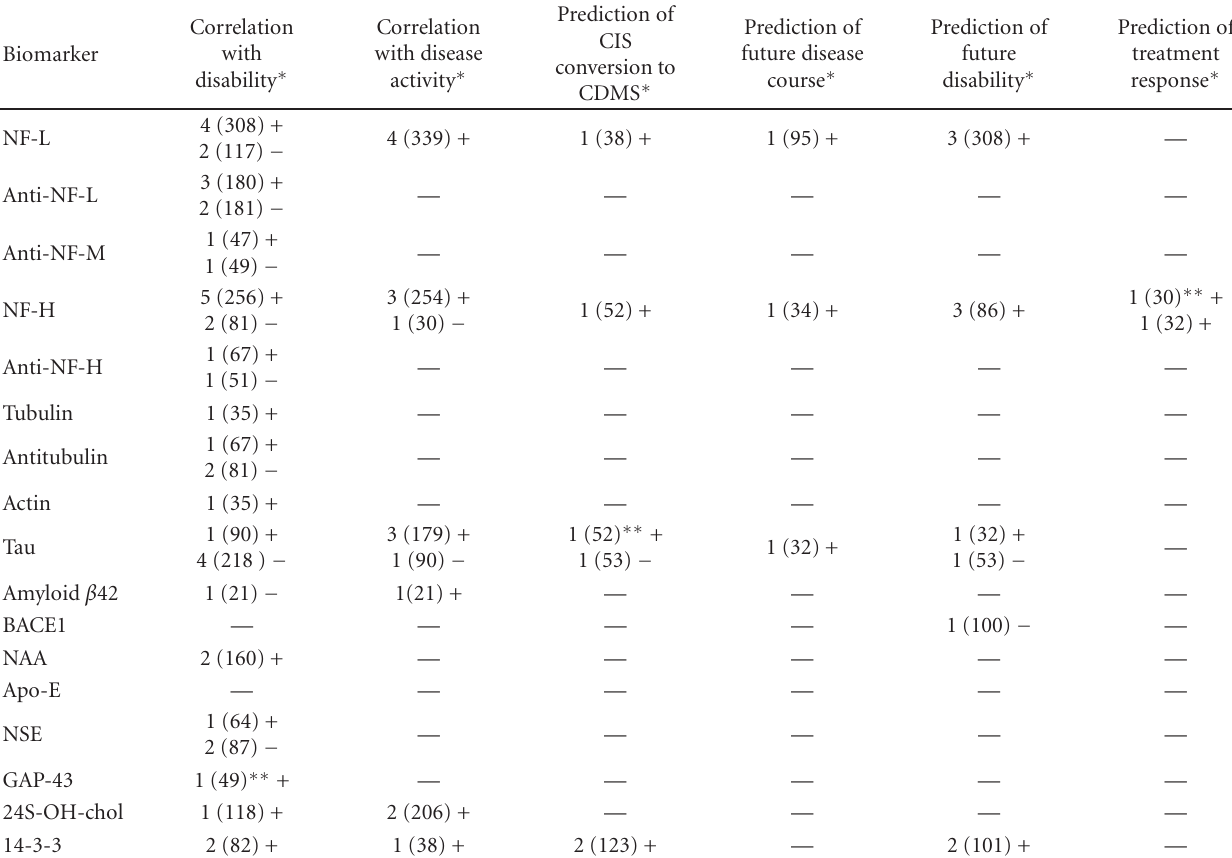
∗ Number of positive (+) or negative ( − ) studies with total number of patients included (in brackets); ∗∗ a tendency; CDMS: clinically definite MS;